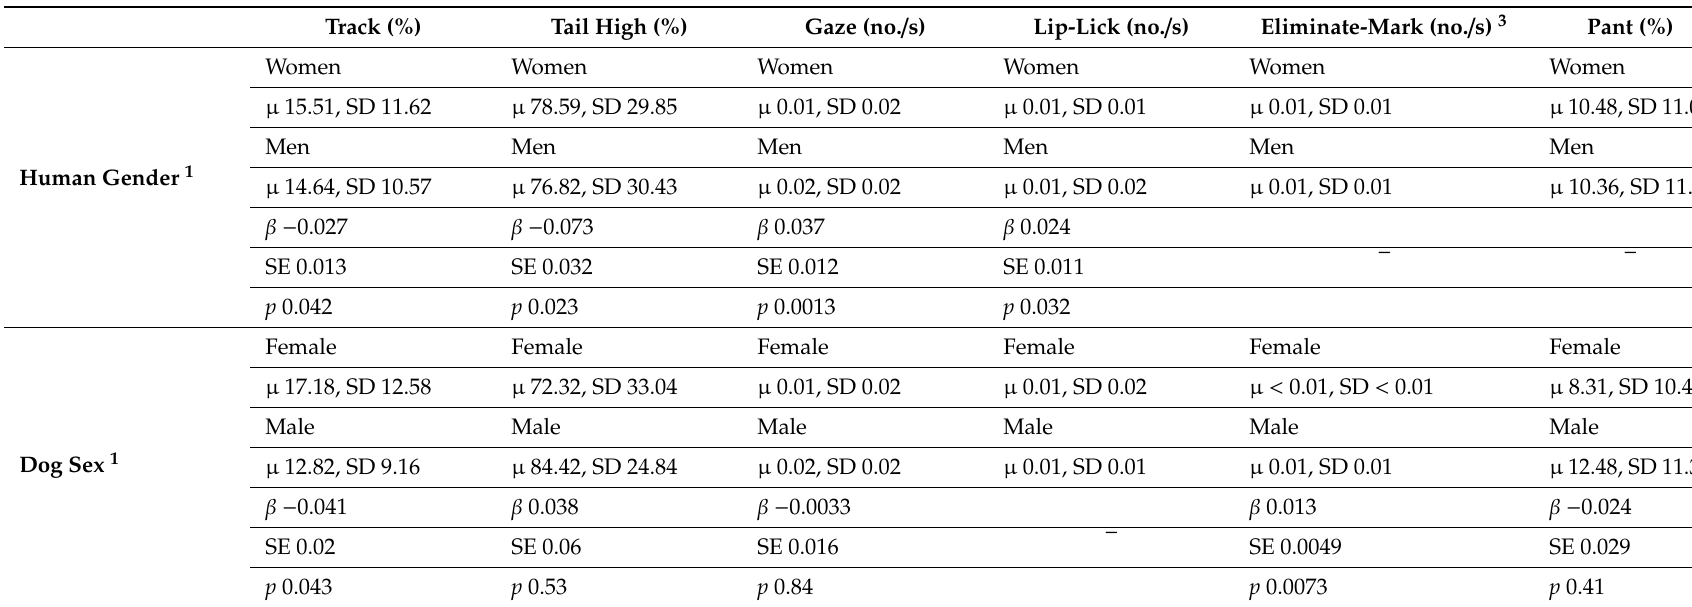
Table 7. Generalized linear mixed model of dog sex and human gender e ff ects on canine behaviour. Mean ( µ ) and standard deviation (SD) of di ff erent dependent variables by gender / sex was